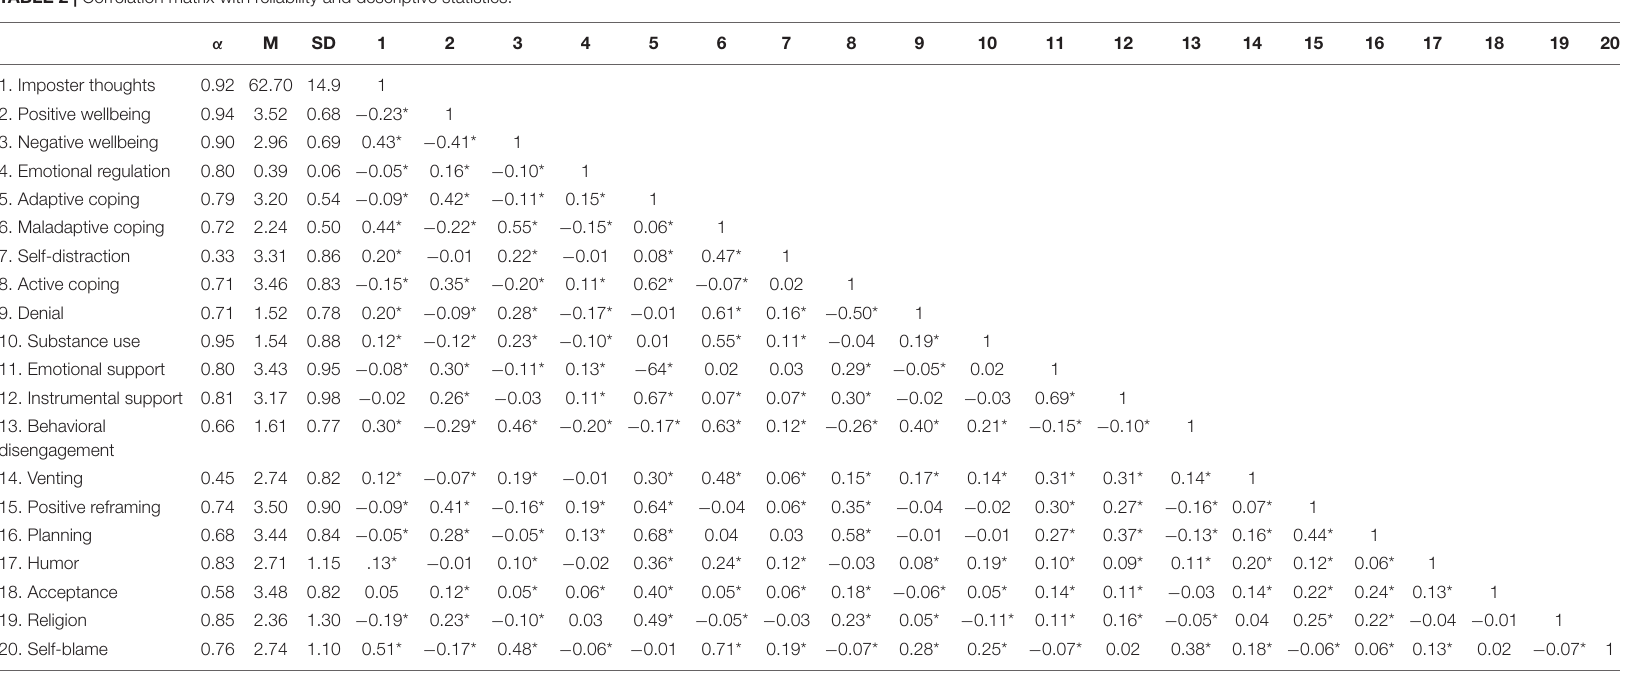
TABLE 2 | Correlation matrix with reliability and descriptive